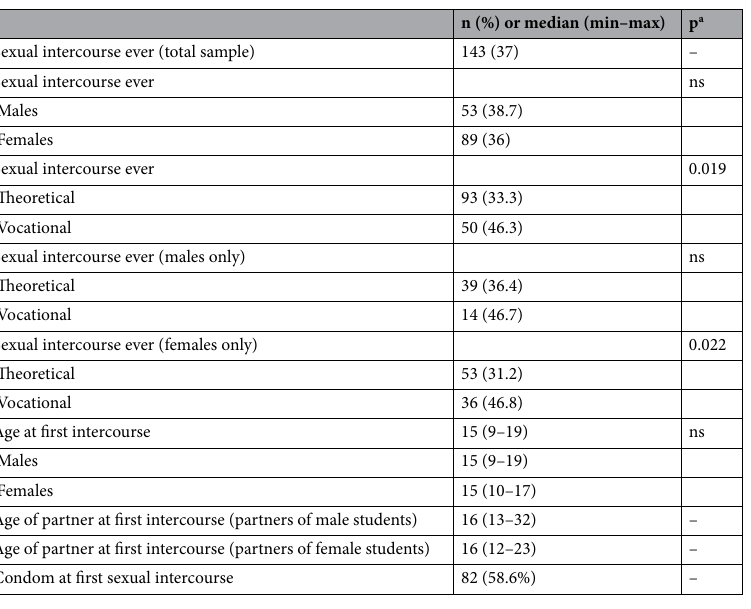
Table 2. Sexual experience and related parameters among first-year high-school students in total, as well as stratified by gender and study program. a Pearson chi-square or Fisher’s exact